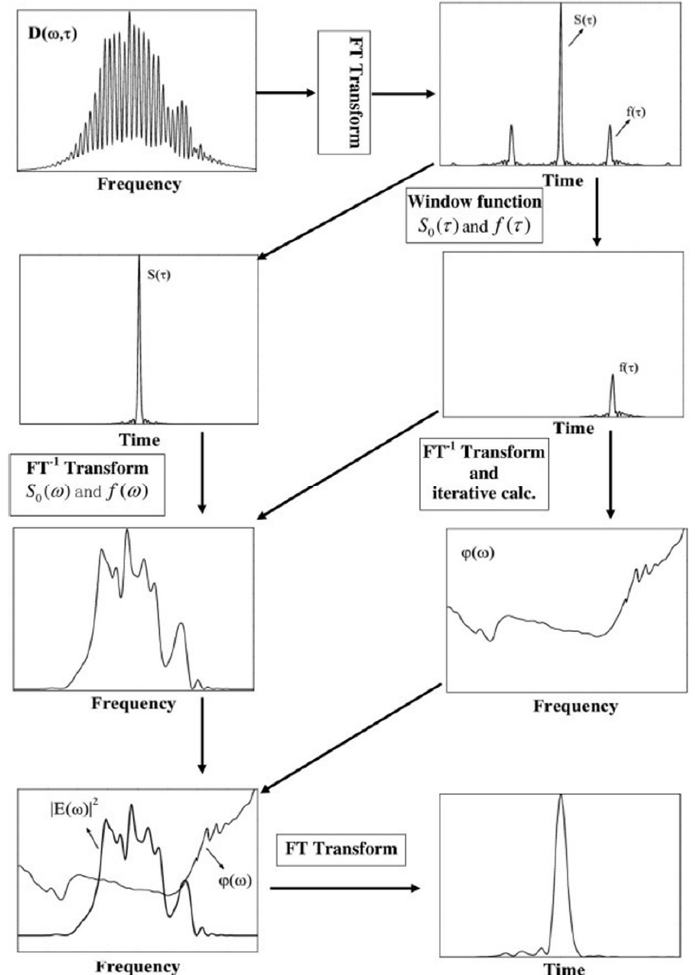
Figure 2. Fourier transform spectral interferometry (FTSI) procedure for calculating the temporal profile of an unknown pulse in the SI method. FT Transform = Fourier transform and FT − 1 Transform = inverse Fourier transform [43].